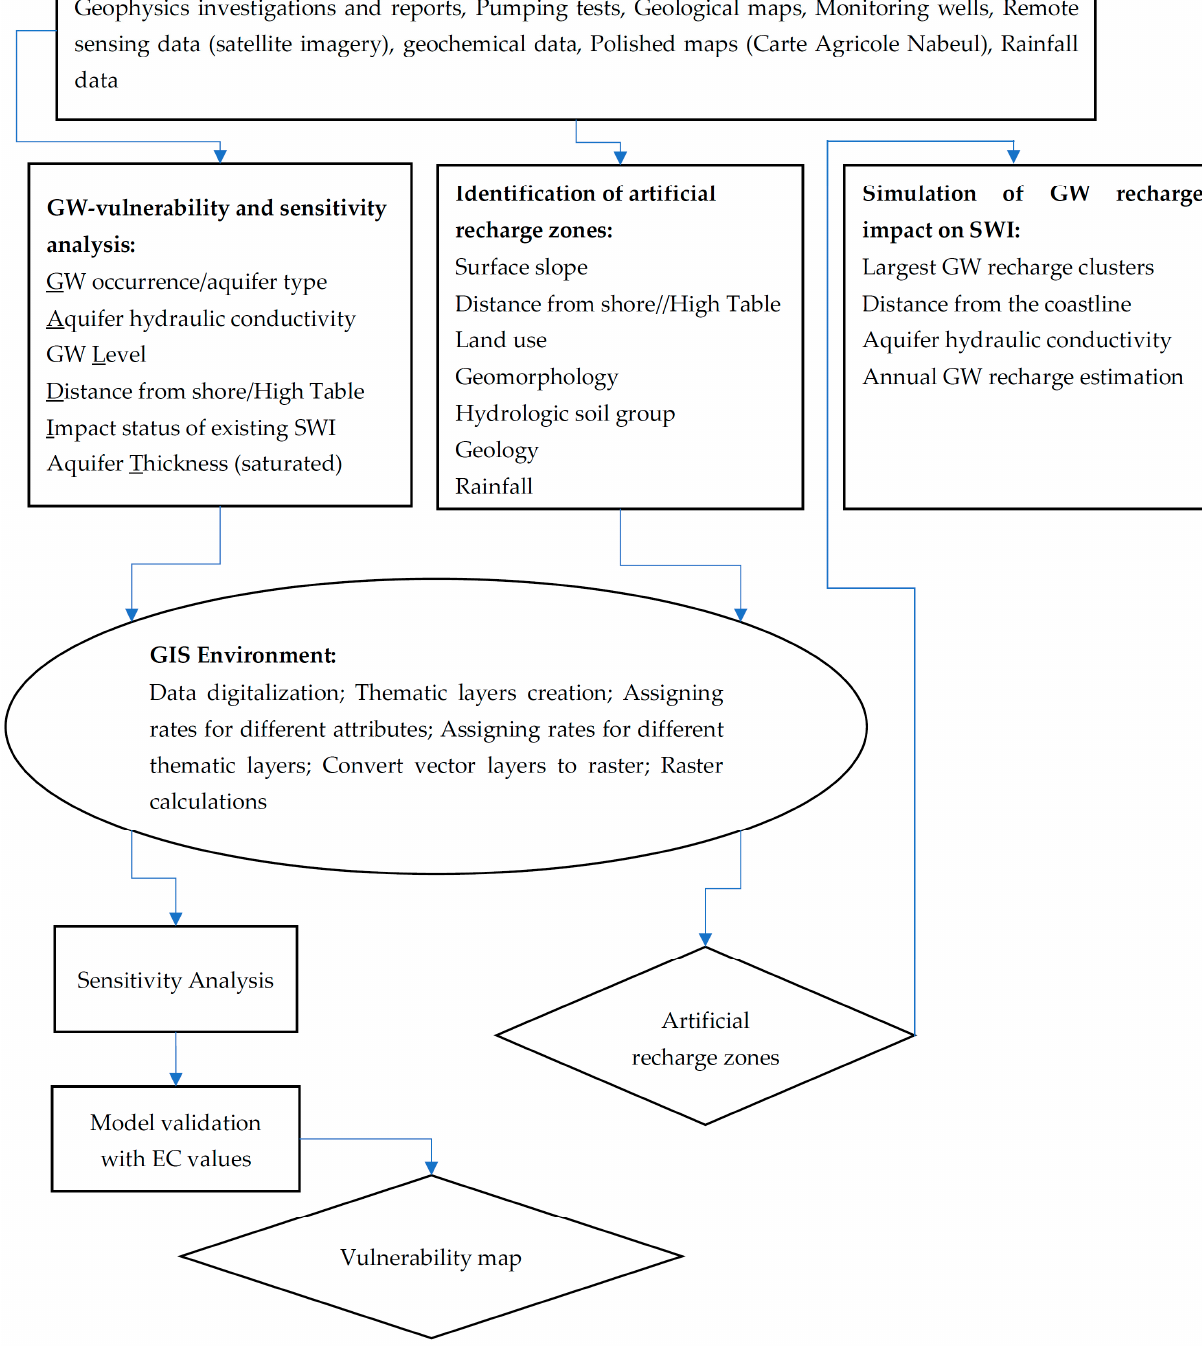
Figure 2. Methodological flowchart.